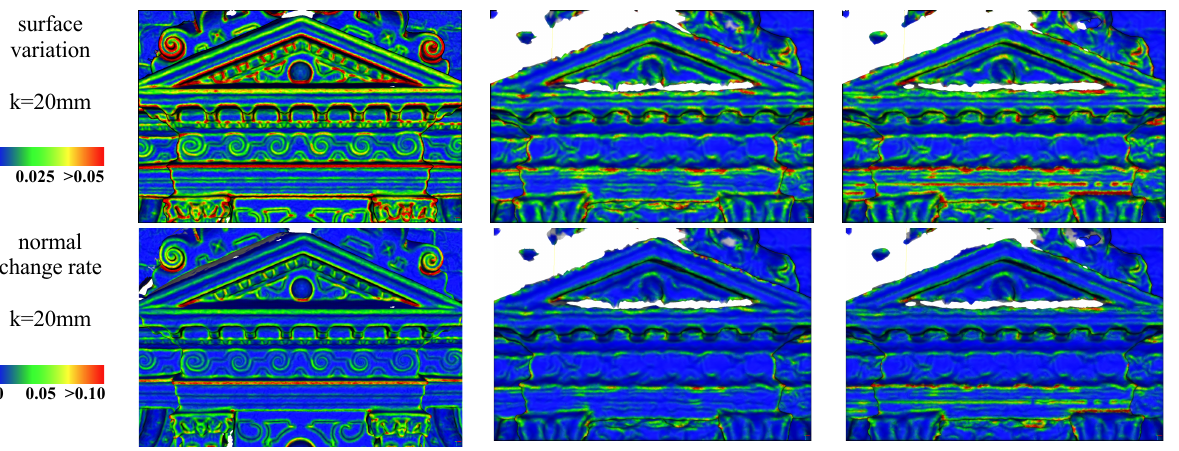
Figure 6. Fountain-P11: surface variation and normal change rate for GT (left), standard mesh (centre), mesh with edges (right).